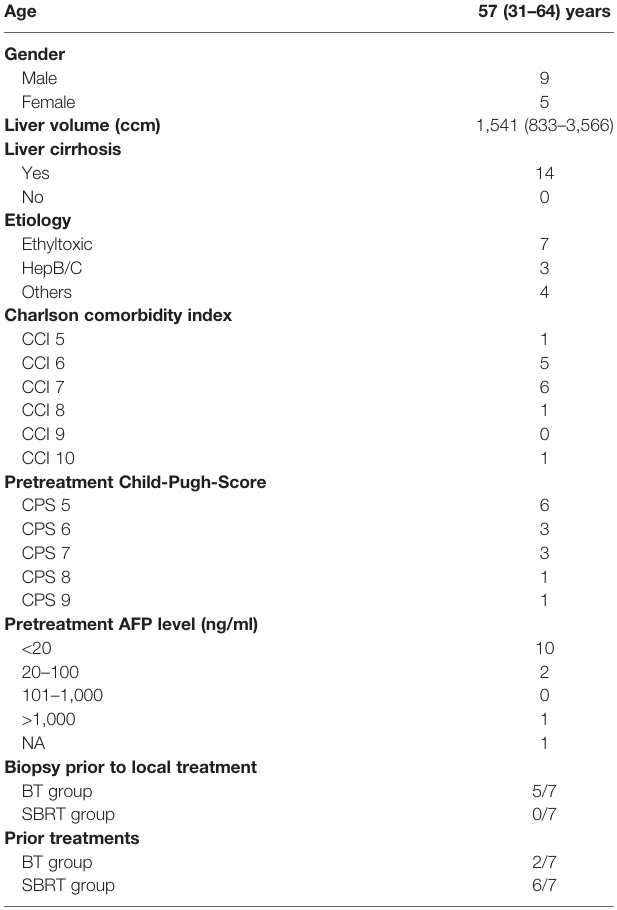
TABLE 1 | Patient